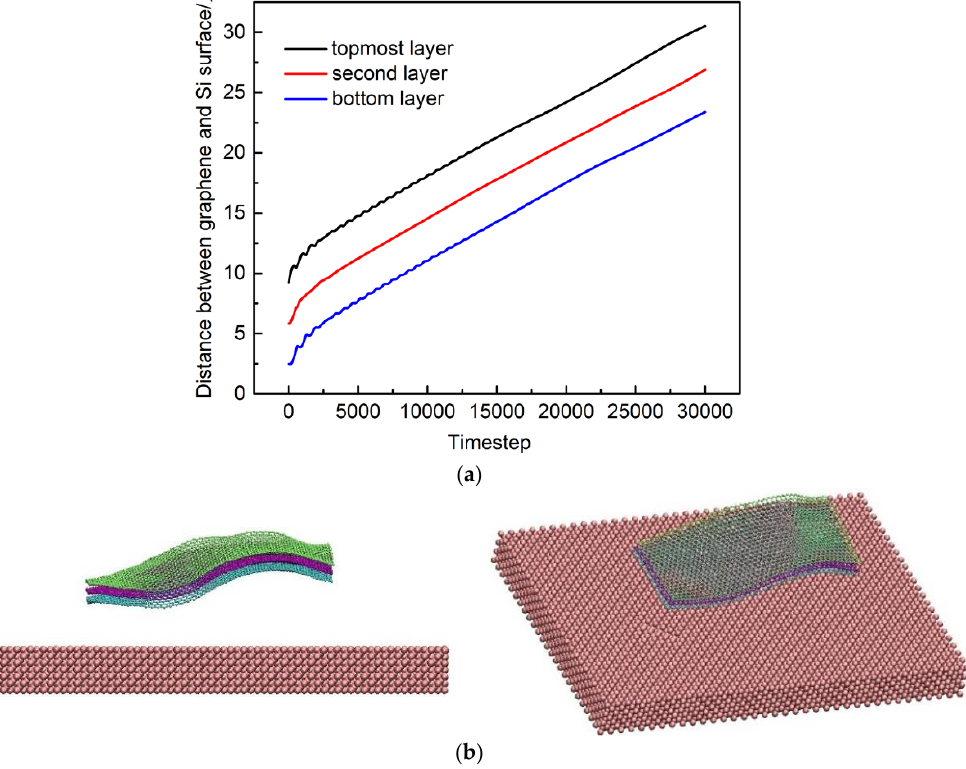
Figure 3. Adhesion behavior in a three-layer graphene system, when the vertical upward velocity is 6.98 Å /ps: ( a ) The variation of distance between graphene and the Si substrate surface with timestep; ( b ) atomic trajectory of the three-layer graphene system.